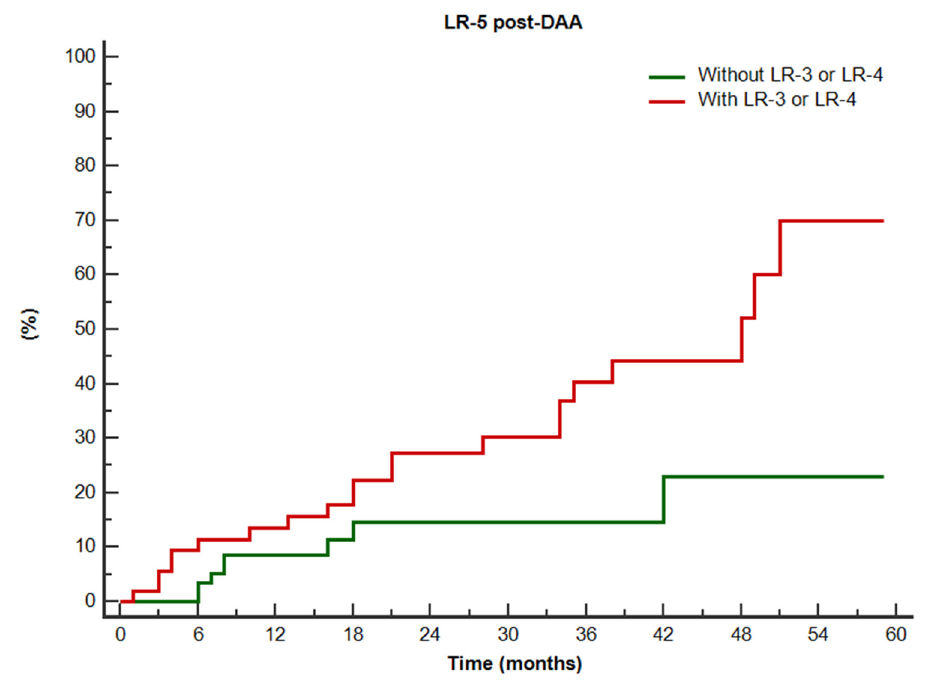
Figure 5. Cumulative Kaplan-Meier curves for LR-5 occurrence after direct acting antivirals, according to the presence of other LR-3 or LR-4 observations. Log-rank p for comparison of curves: 0.024.